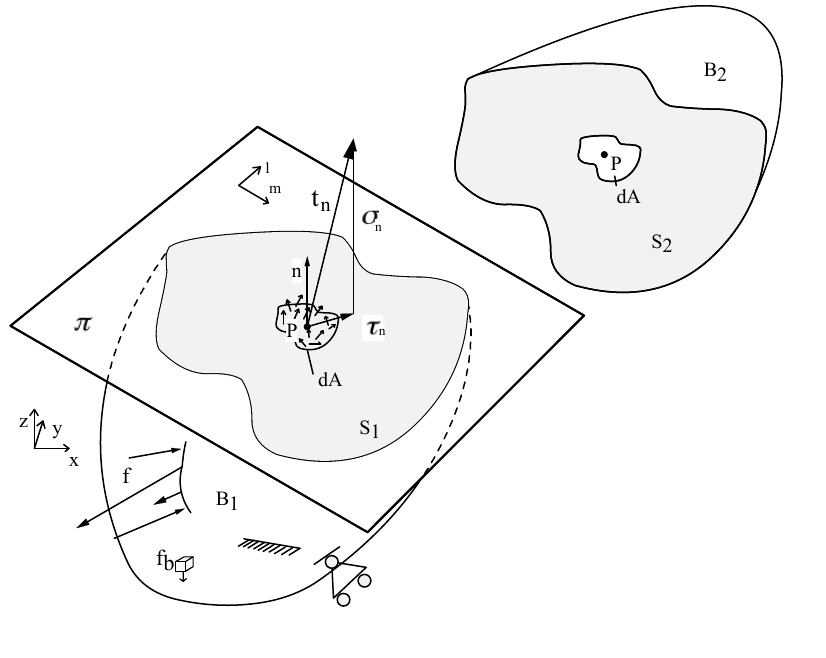
Fig. 1 Scheme of the total stress vector at point P of a solid body under generic boundary conditions, body forces, and surface